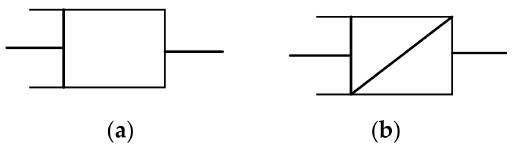
Figure 1. ( a ) Newton dashpot; ( b ) Able